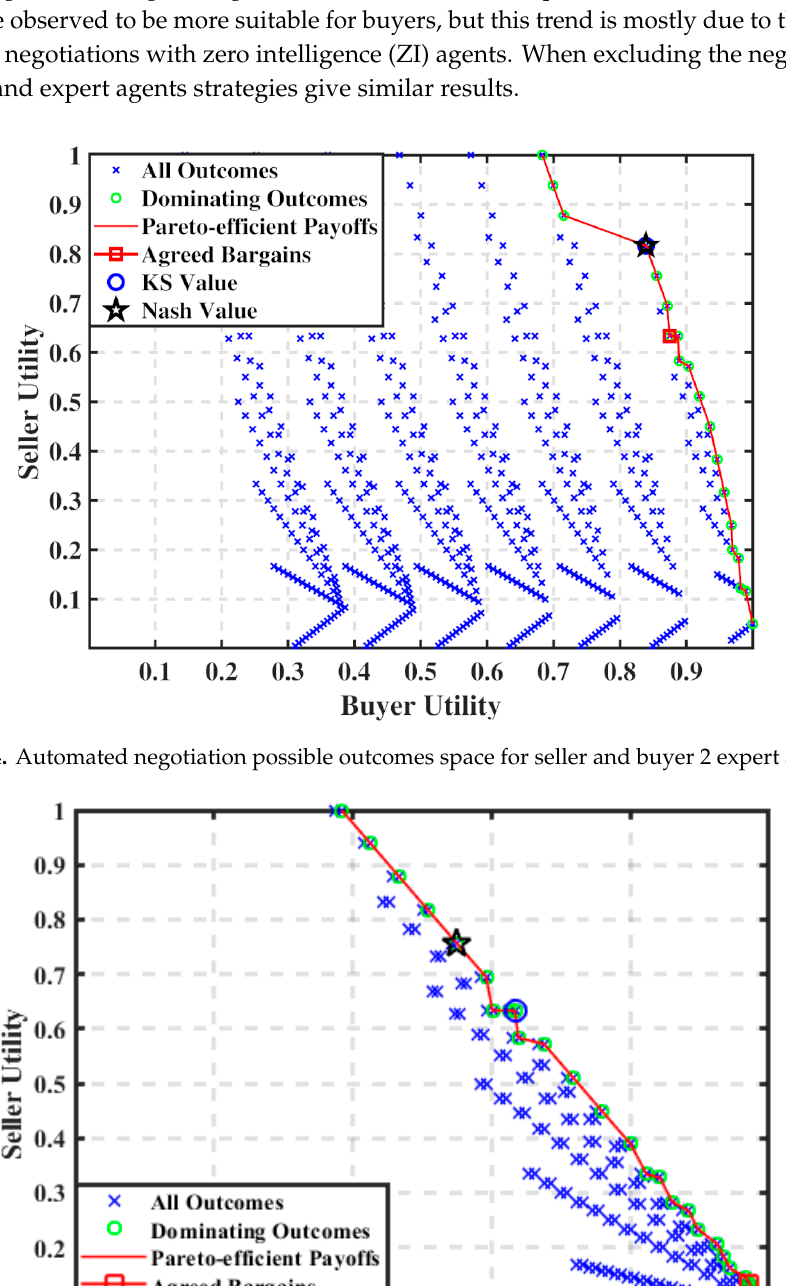
Figure 3. Automated negotiation possible outcomes space for seller and buyer 1 expert agents.